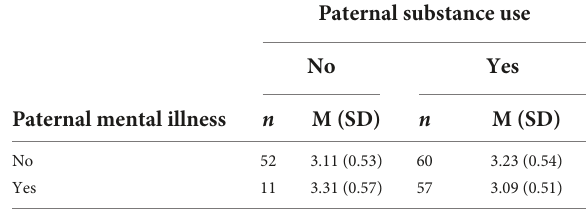
TABLE 3 Descriptive statistics for mothers’ mean RF by family history of paternal mental illness and paternal substance